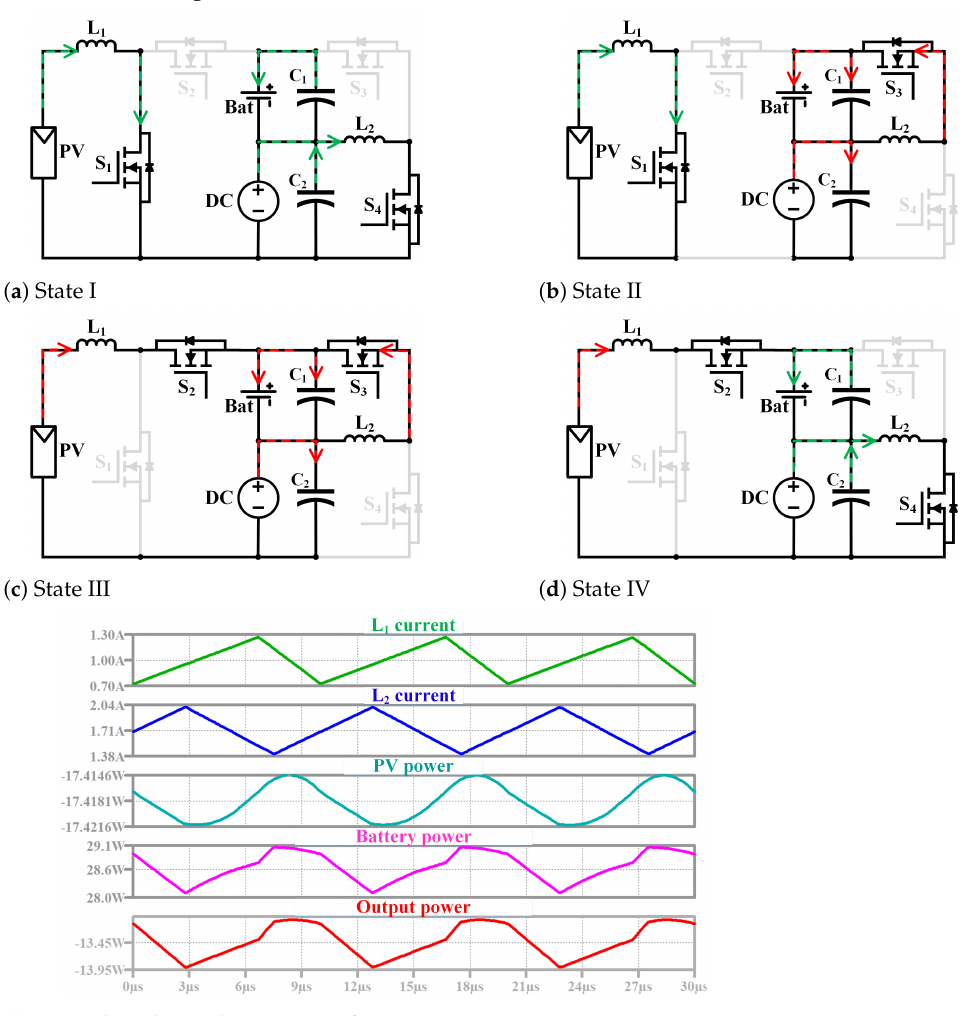
Figure 13. Type I-III-IC circuit Mode 7 DISO. State IV [ t 3 < t < t 4 ]: S 2 and S 4 are turned ON while S 1 and S 3 are OFF. L 1 continues to discharge into the battery and L 2 starts be charged from DC bus, as shown in Figure 13d. When S 1 turns ON at t = t 4 , this state ends. The simulation waveforms are shown in Figure